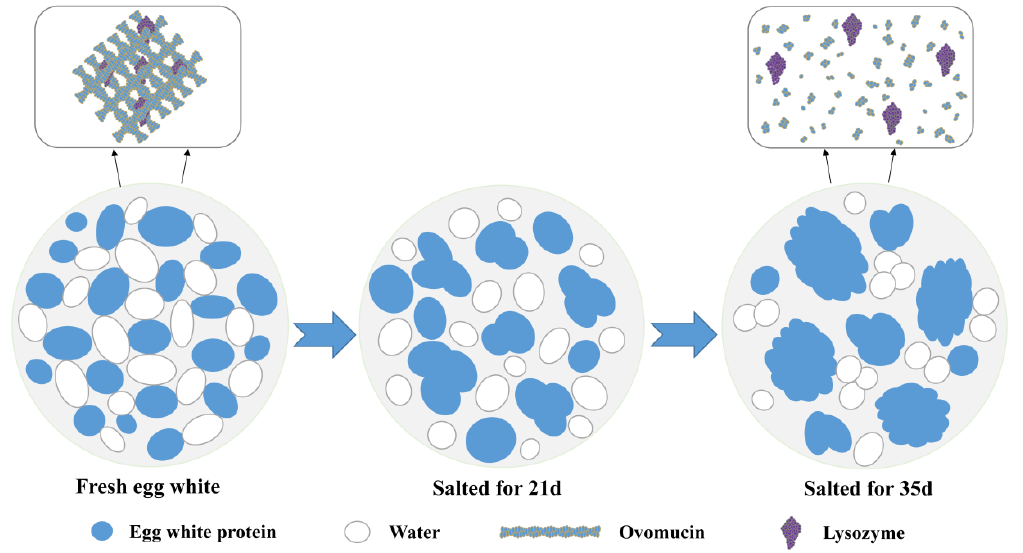
Figure 2. Diagram of hydration mechanism of salted egg white.